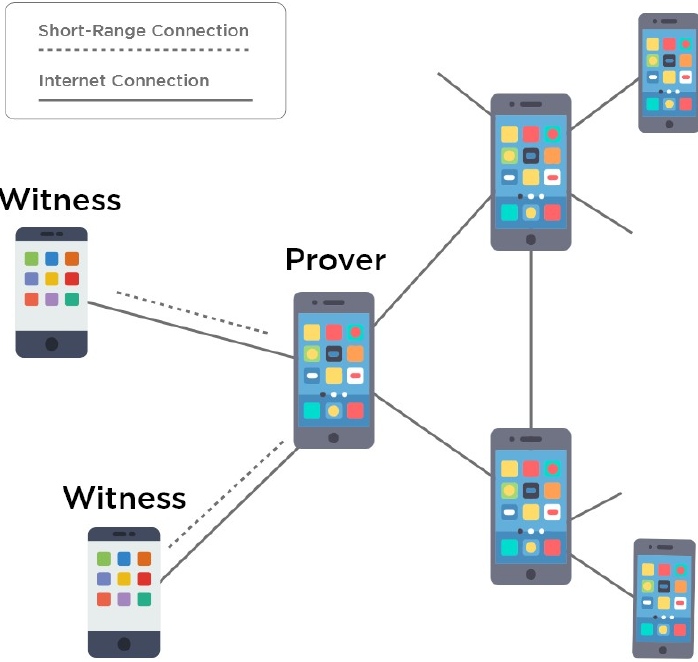
Figure 11. Proof of location.